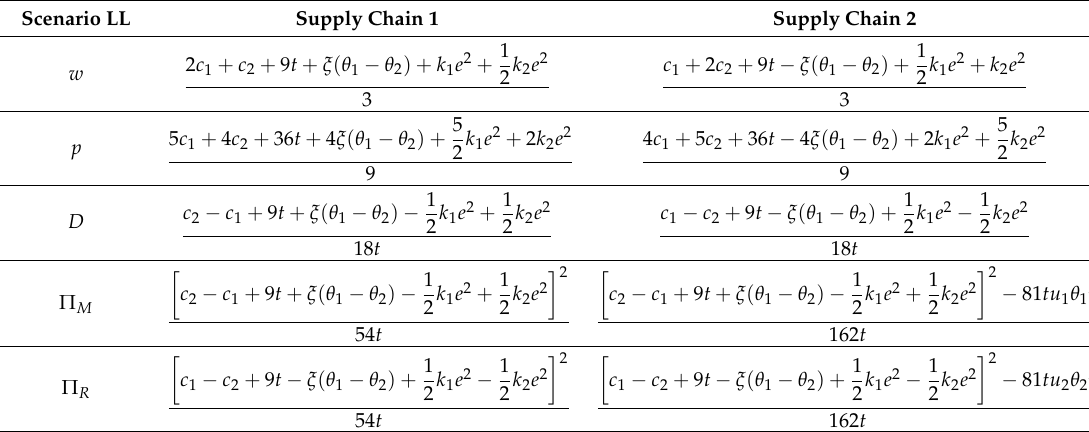
Table A4. Equilibrium outcomes under scenario